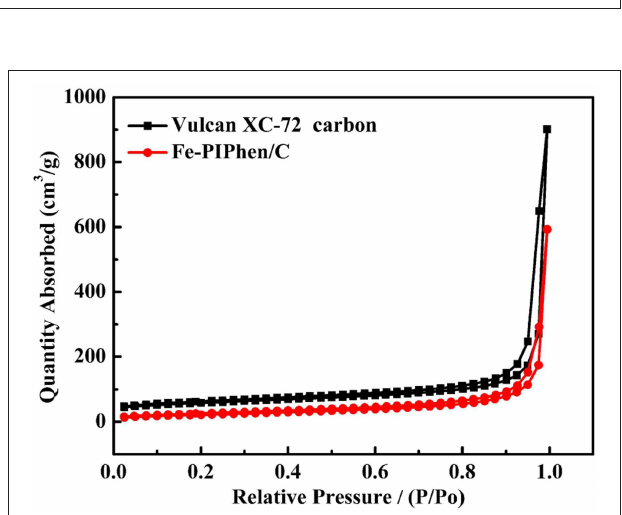
FIGURE 2 | SEM images of Vulcan XC-72 carbon (A) , Fe-PIPhen/C (B) .